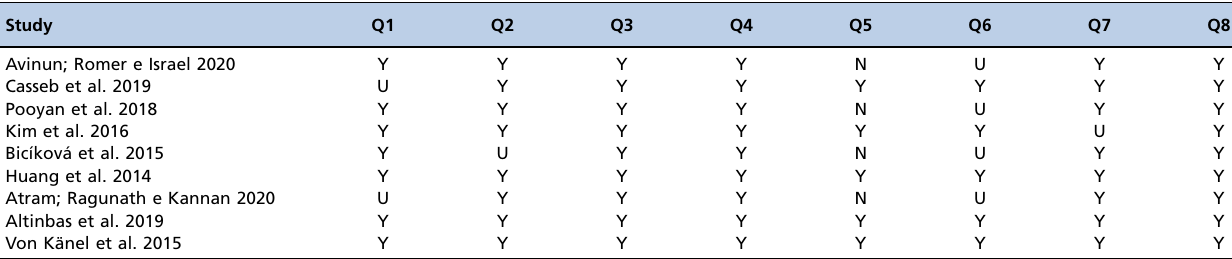
Table 1 - Critical appraisal results for included studies using the Joanna Briggs Institute for verification of cross-sectional analytical studies. Study